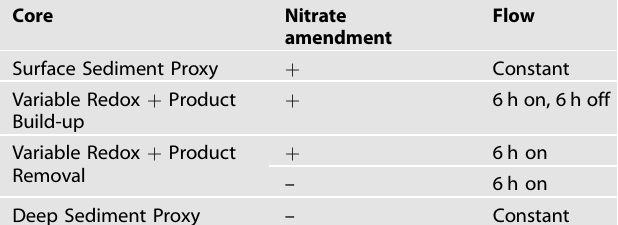
Table 1. Conditioning